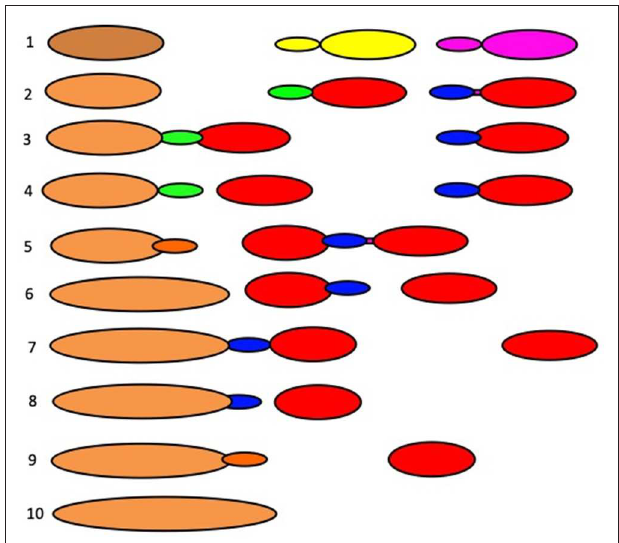
FIGURE 10 | The scheme explains why the Golgi complex disappears after block of cargo exit from the ER in S. cerevisiae . The postulates are the same as in Figure 9